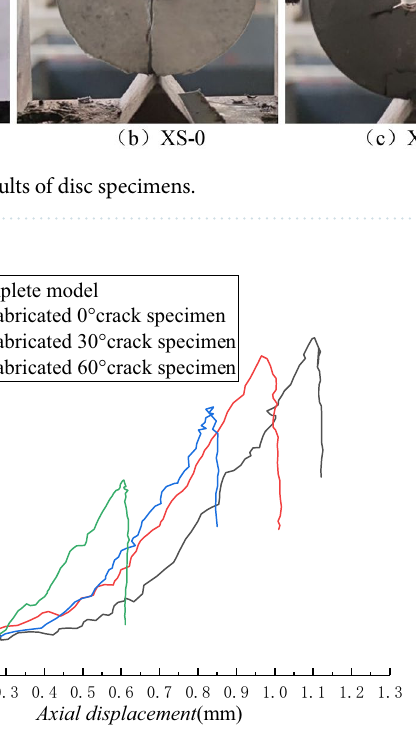
Figure 4. Axial force–displacement curves of different samples in the whole shear